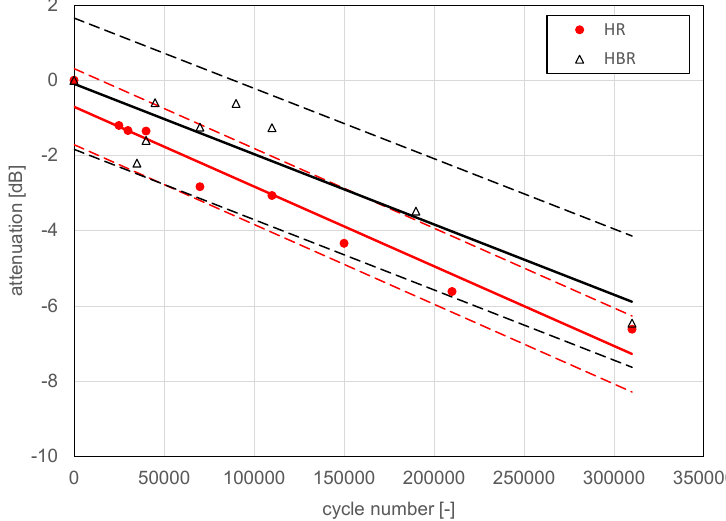
Figure 17. Evolution of measured signal amplitudes over cycle number for sender at position HBL and receiver in transmission mode at the positions HR and HBR, with linear regression curves for each position (mean curves solid, ±2 standard deviation curves dashed).